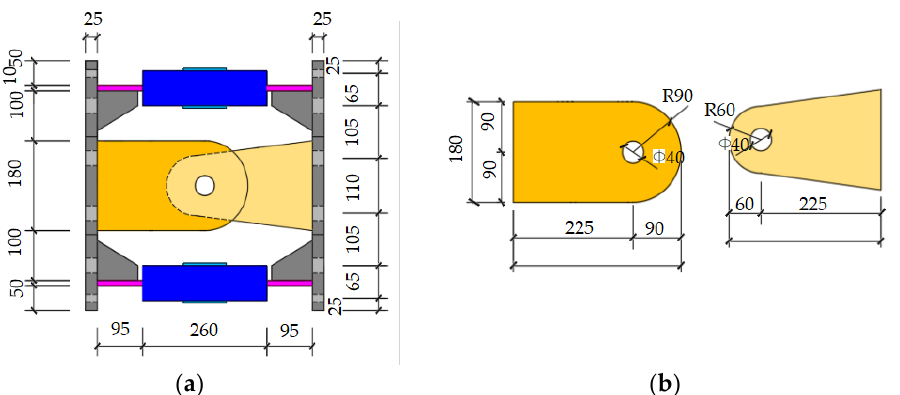
gy-dissipating steel hinge; ( c ) configurations of the beam and column; ( d ) front view of the steel sleeve confined concrete joints (unit: mm). sleeve confined concrete joints (unit: mm). sleeve confined concrete joints (unit: mm).